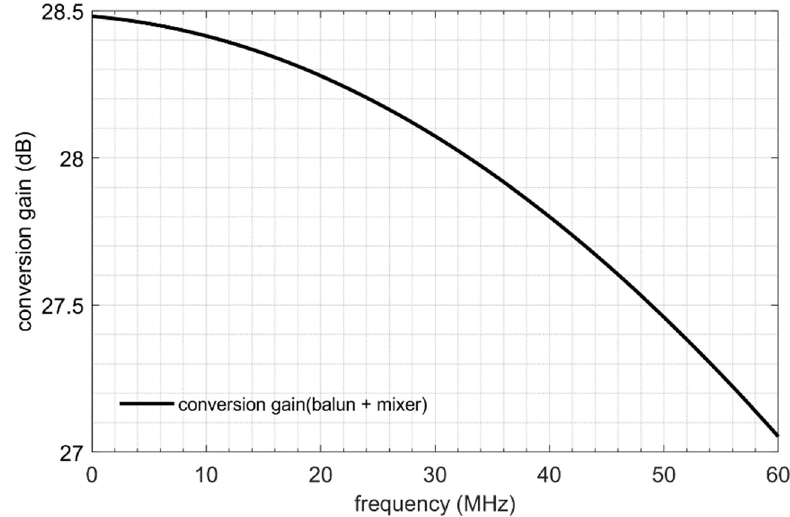
Figure 17. Voltage conversion of the balun and mixer.